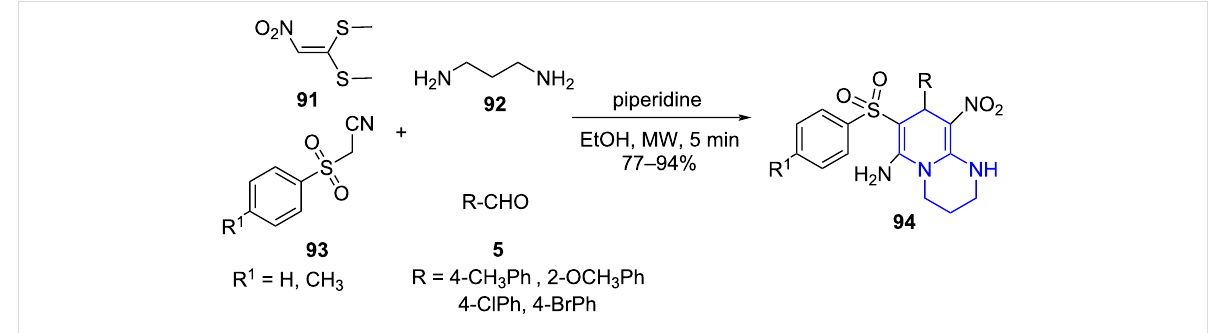
Scheme 34: Synthesis of